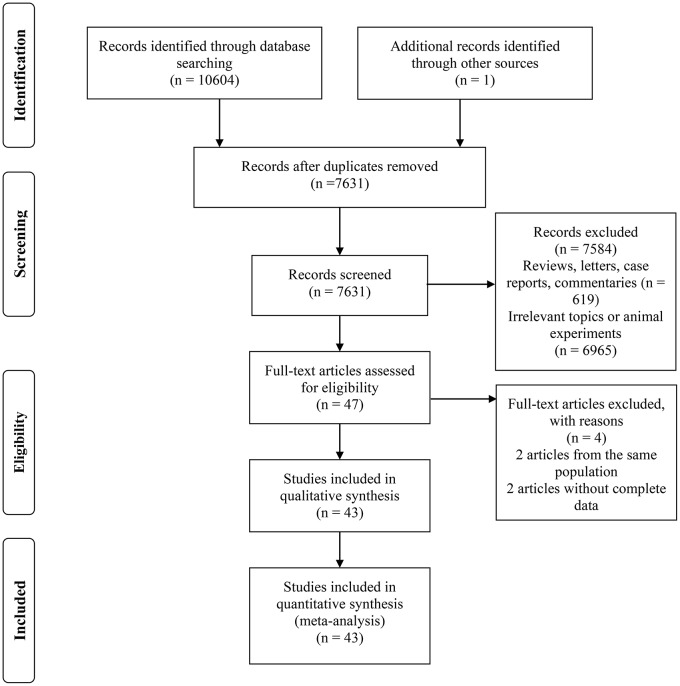
The PRISMA trial flow diagram for identifying and selecting articles.